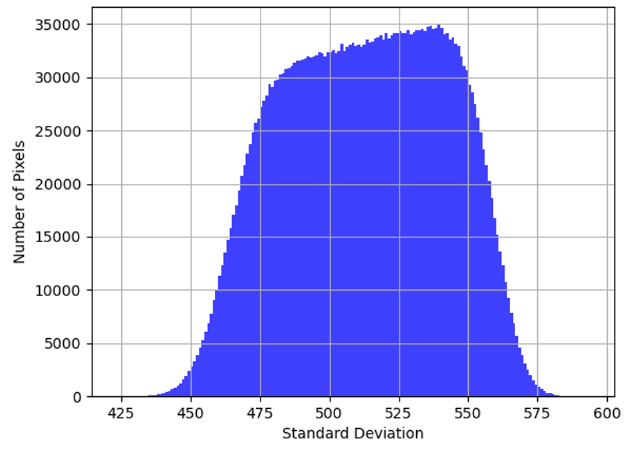
Figure 16. Distribution of per-pixel SD at T = 30 ◦ C, α = 0.0